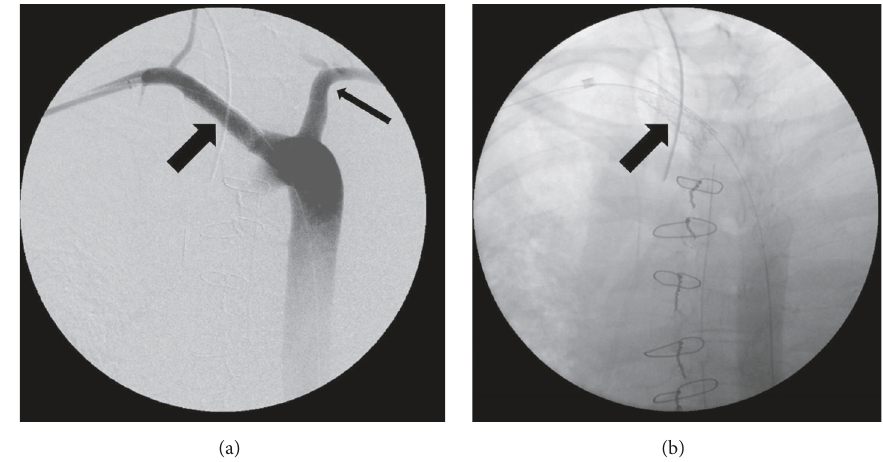
Figure 2: (a) Intraoperative angiogram performed in an AP projection through a sheath positioned in the right axillary artery from a right brachial approach. The right subclavian artery is seen (wide arrow) as is the left subclavian artery (narrow arrow). (b) Intraoperative image in the same projection after deployment of a balloon expandable covered stent at level of esophageal-arterial communication. The arrow indicates the position of the covered